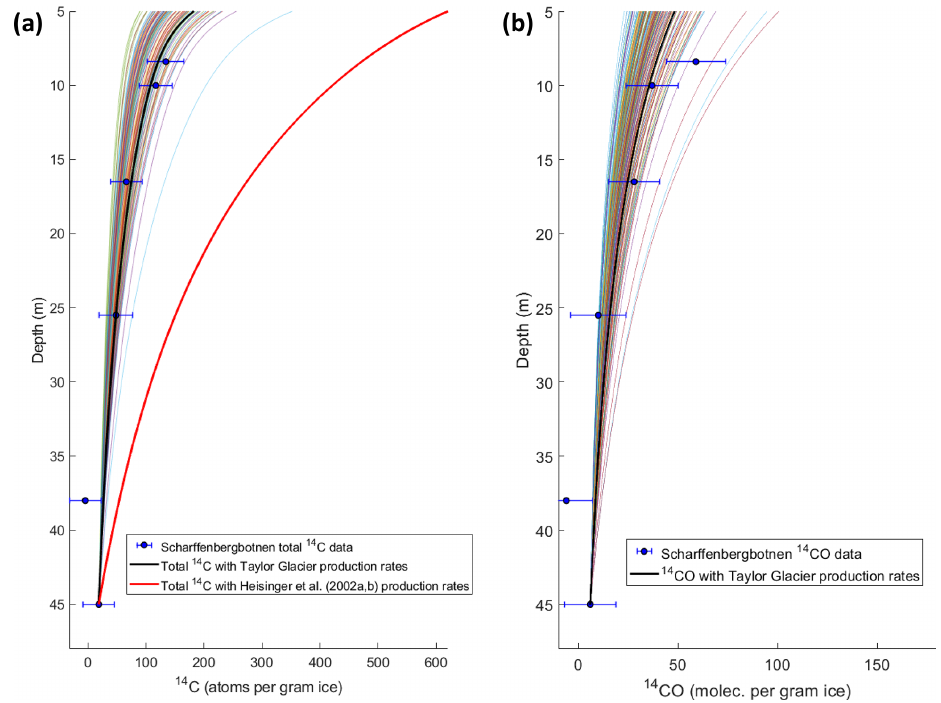
Figure 8. (a) Comparison between measured total 14 C from Scharffenbergbotnen, expected total 14 C using the production rates inferred in this study, and expected total 14 C using the Heisinger et al. (2002a, b) production rates. (b) Comparison between measured 14 CO from Scharffenbergbotnen and expected 14 CO, using the production rates inferred from Taylor Glacier. The colored lines in both figures represent the 95% CI envelope of the model results. At the depths plotted in this figure (deeper than 5m), the production from neutron-induced spallation is